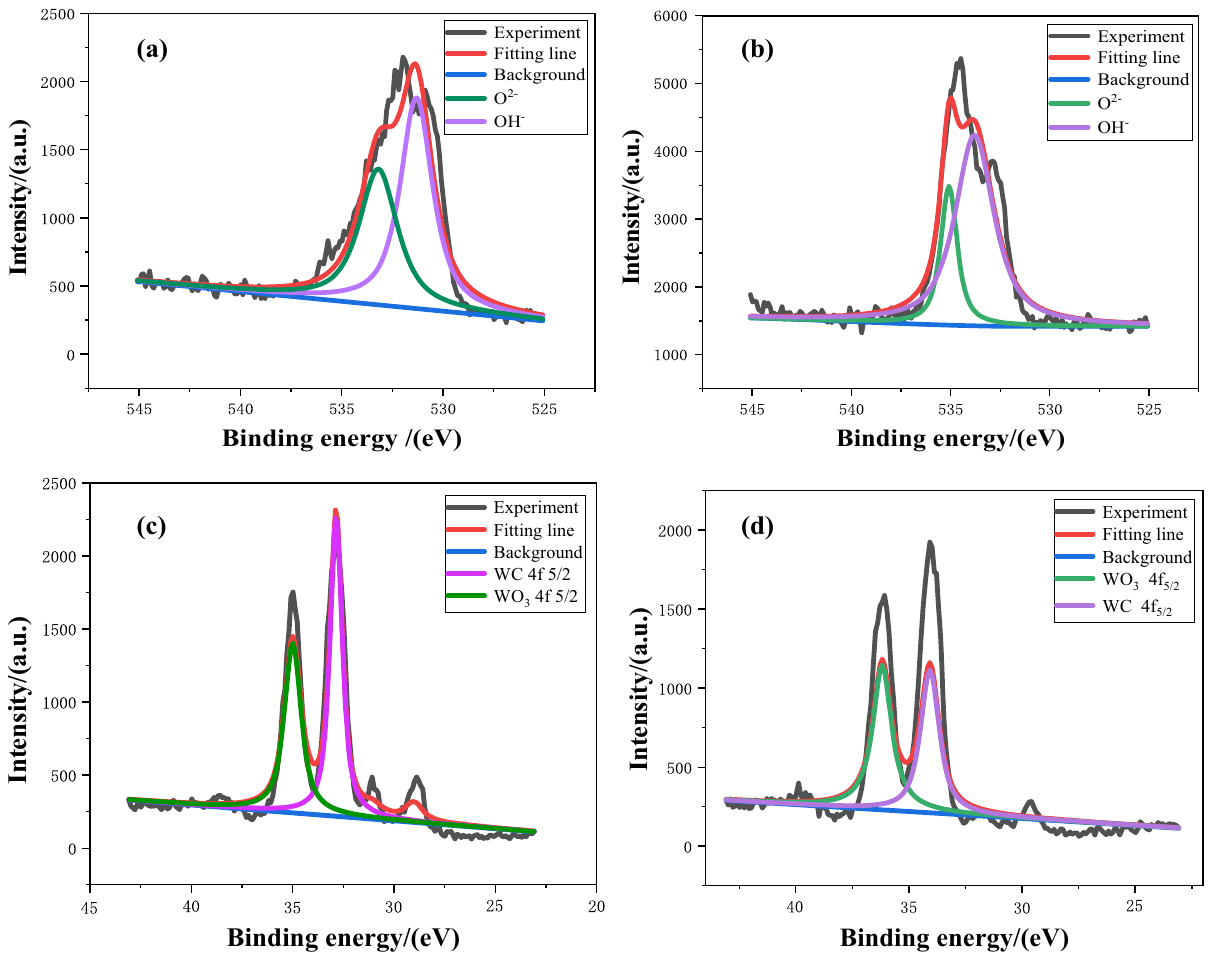
Figure 12: XPS spectra of the surface of Co + 45% WC sample after low temperature immersion. ( a ) O 1s in 3.5 wt% NaCl solution; ( b ) O 1s in 0.5 mol · L − 1 HCl solution; ( c ) W4f in 3.5 wt% NaCl solution; ( d ) W4f in 0.5 mol · L − 1 HCl solution.